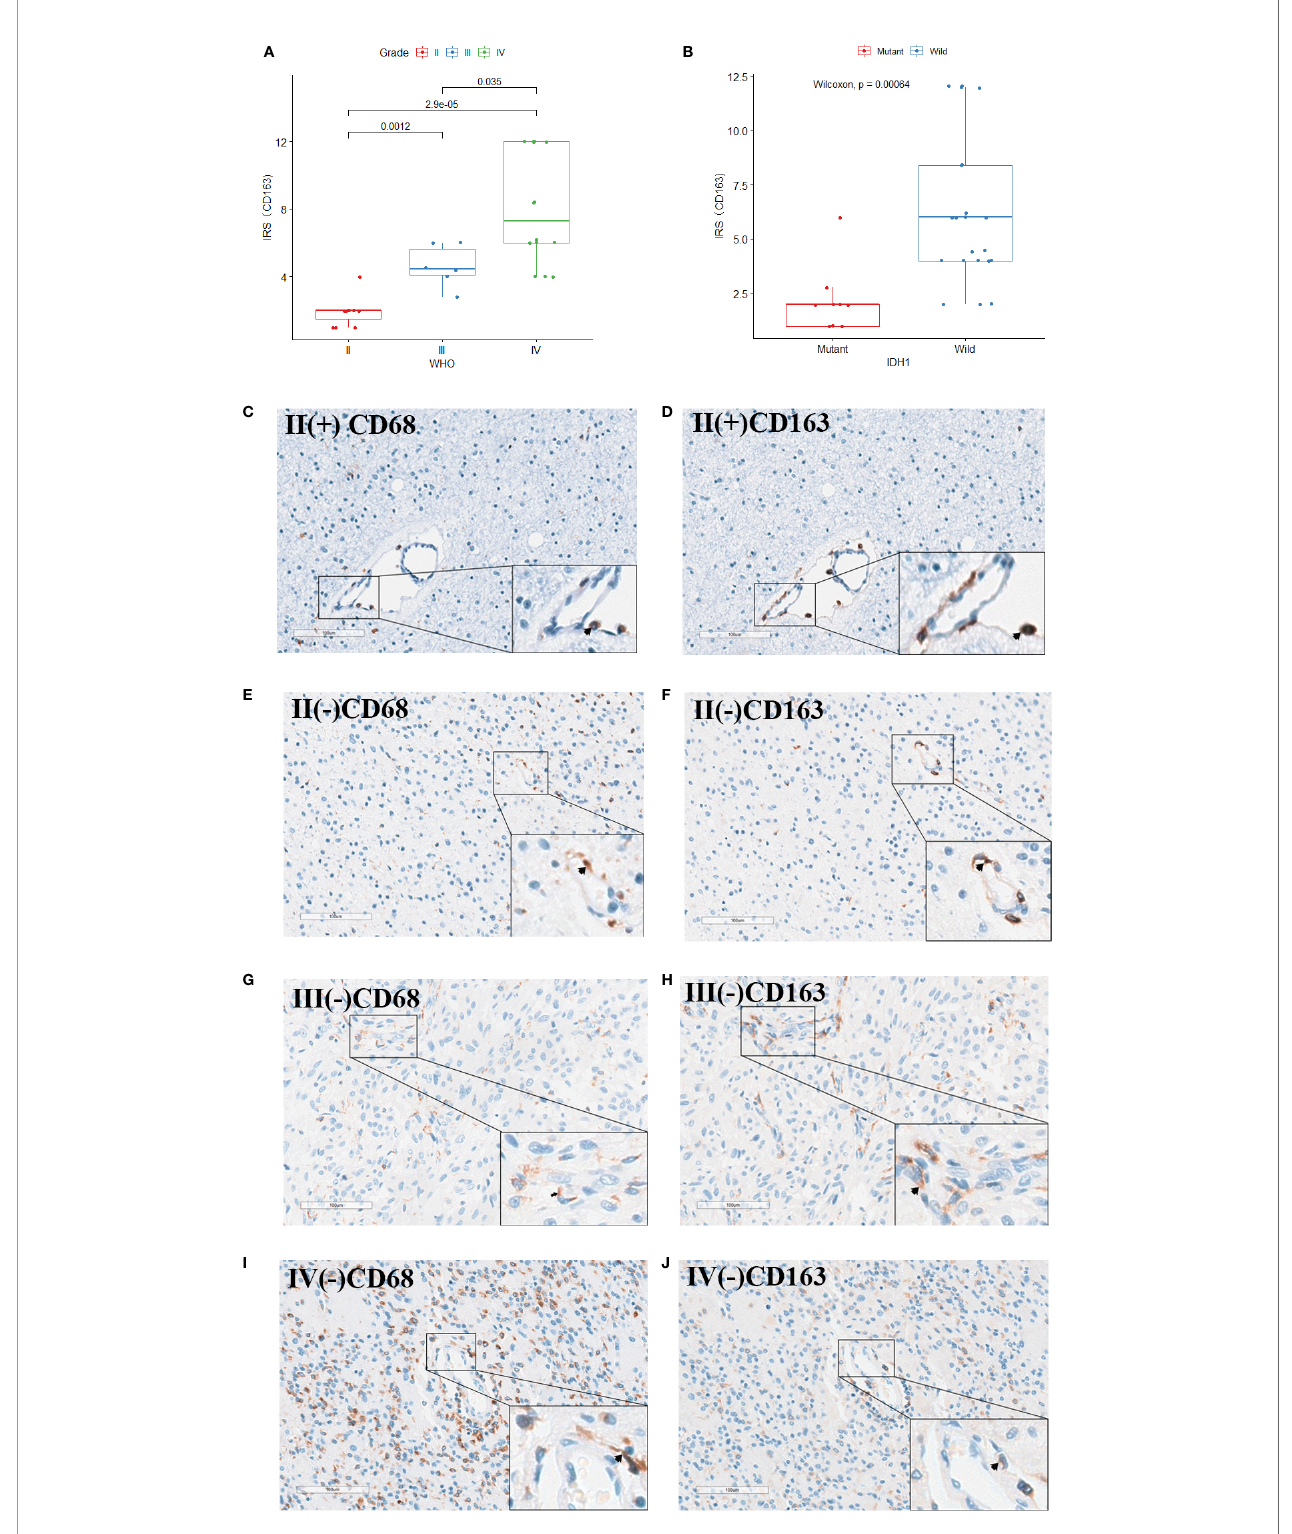
FIGURE 8 | The CD68 and CD163 IHC staining of the 31 glioma patients. (A) CD163 expression was signi fi cantly higher in high-grade gliomas. (B) In the IDH1 mutant cases, the CD163 was signi fi cantly lower as compared to the cases with IDH1 wild cases. (C – J) CD68 and CD163 IHC staining image of adjacent slides in clinical glioma patients with WHO grade II/IDH1(+), WHO grade II/IDH1 ( – ), WHO grade III/IDH1 ( – ) and WHO grade IV/IDH1 ( – ) pathology results